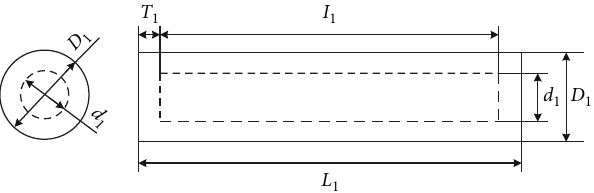
F IGURE 3: Design dimensional parameters of the expansion section